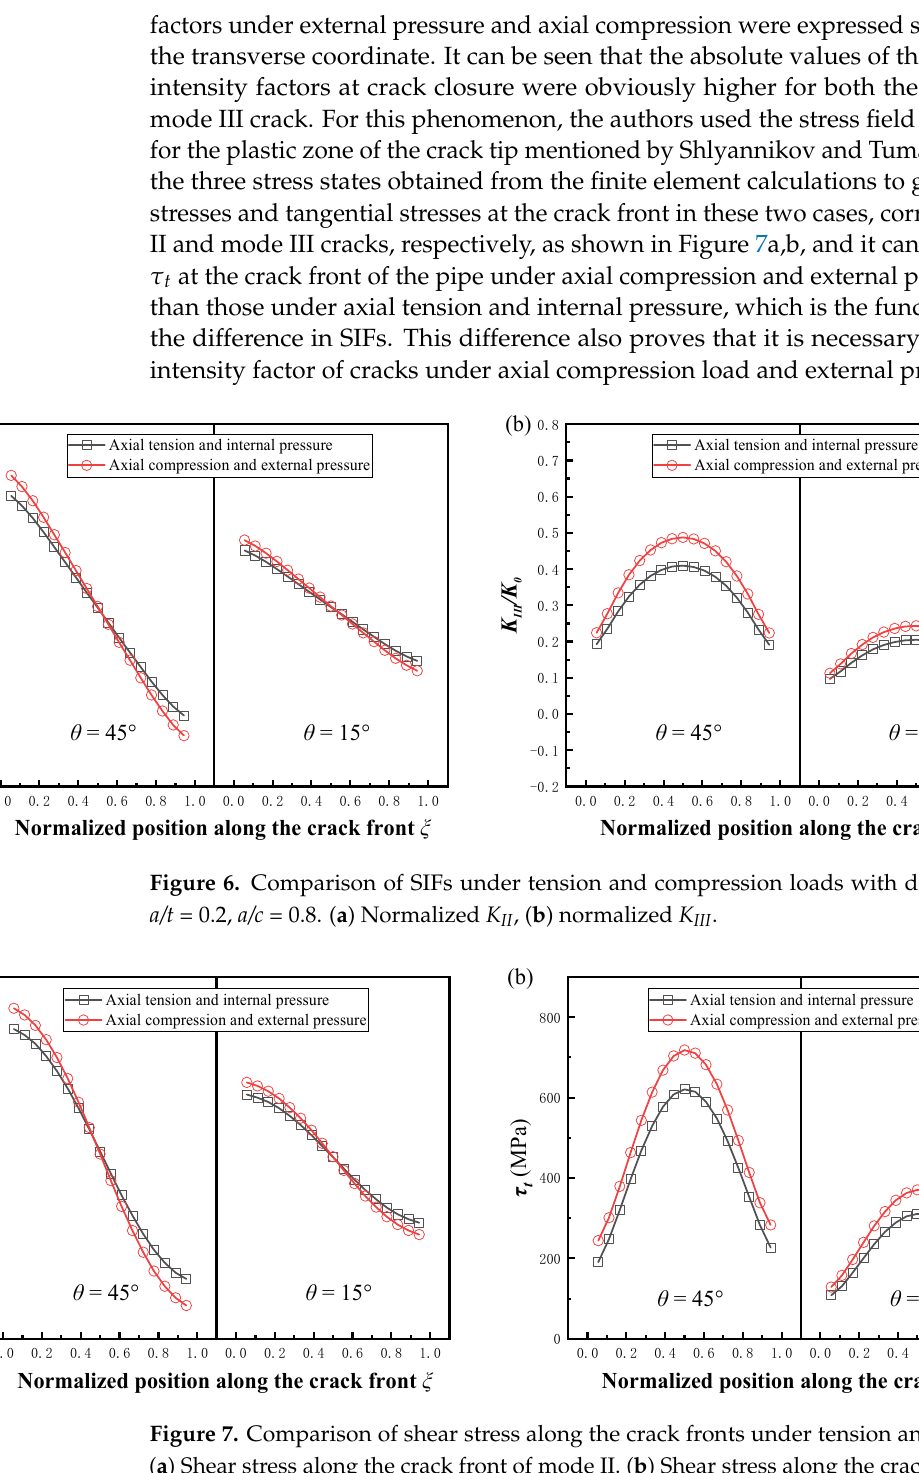
Table 2. Finite element calculation scheme. Influencing Factors a/t